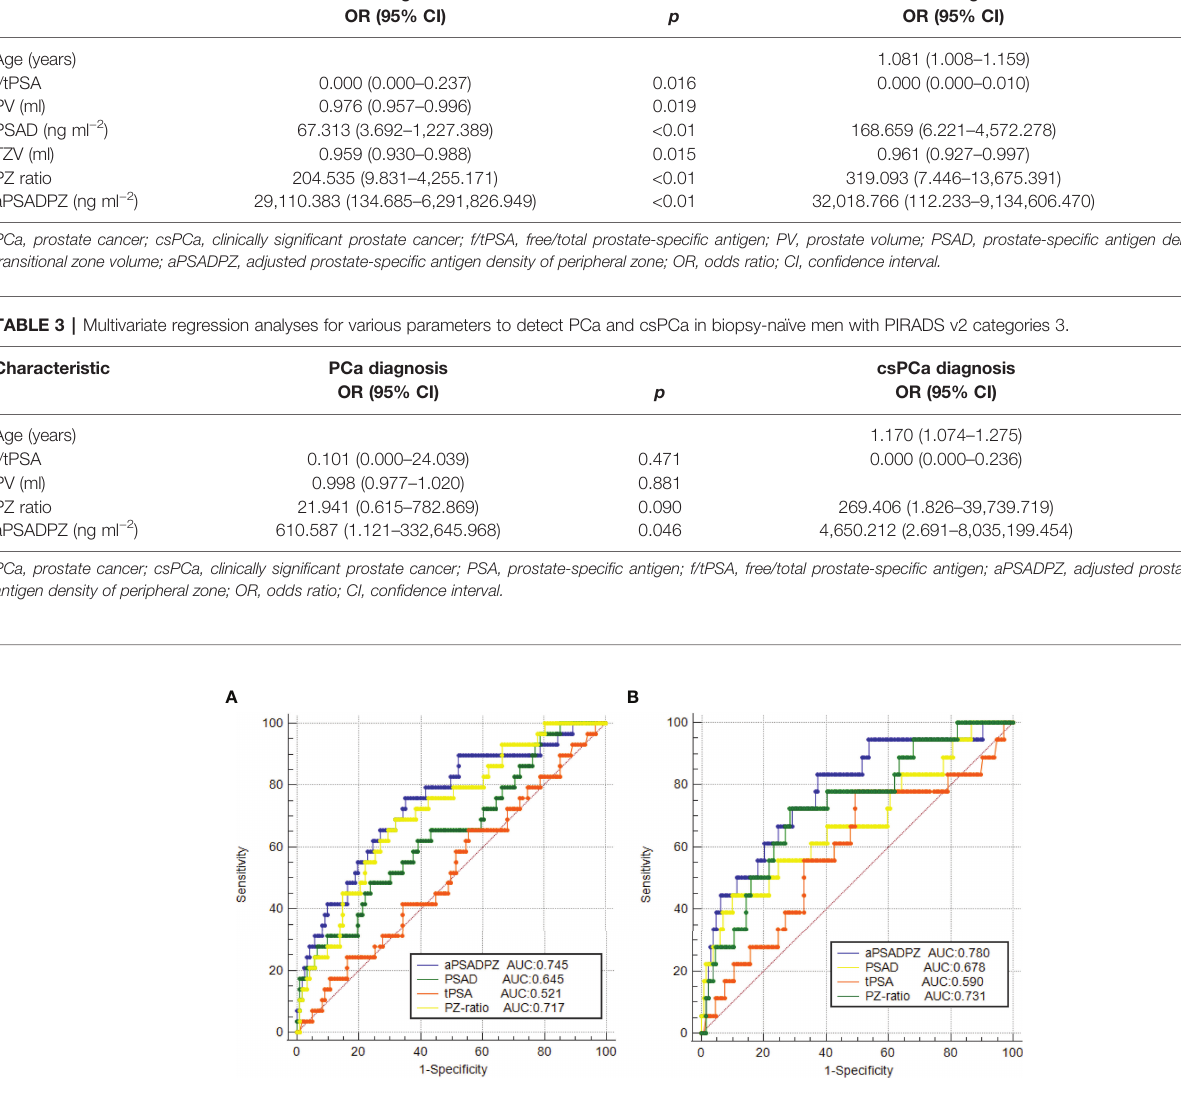
TABLE 2 | Univariate regression analyses for various parameters to detect PCa and csPCa in biopsy-naïve men with PIRADS v2 categories 3.